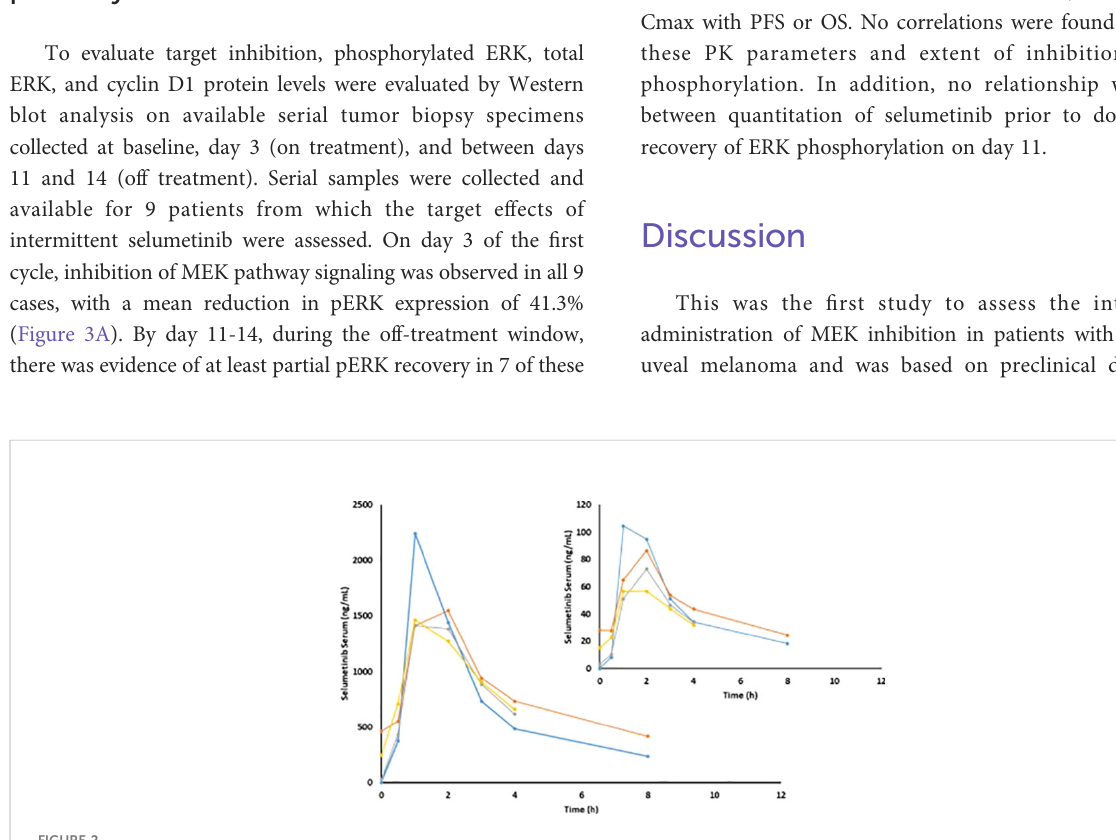
FIGURE 2 Mean selumetinib and N-desmethyl-selumetinib (insert) concentrations on C1D1 (blue), C1D2 (orange), C1D15 (grey) and C1D17 (yellow) in patients at the 125mg dose level